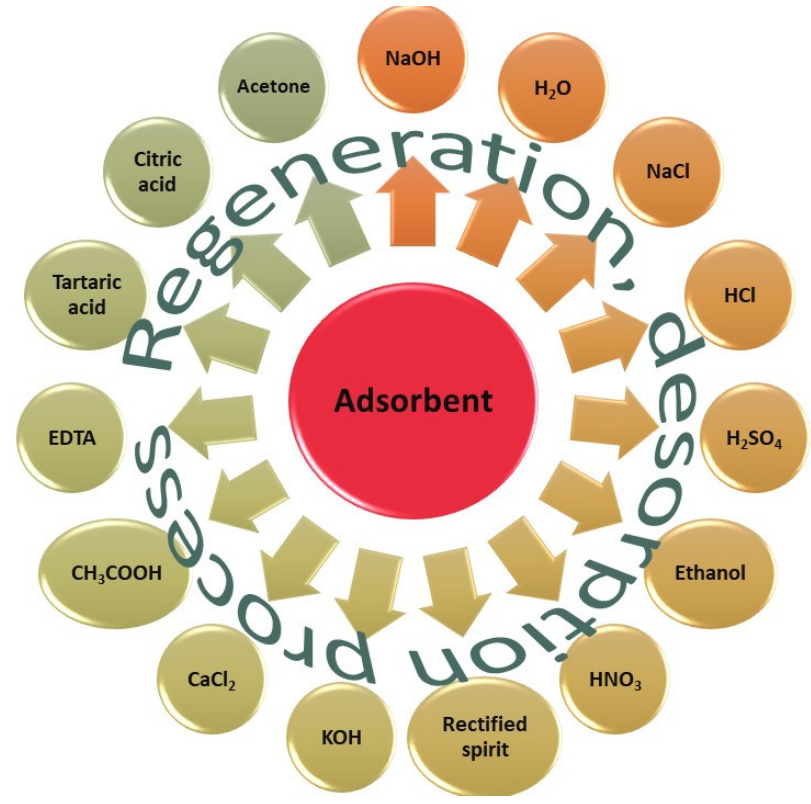
Figure 7. Possible eluents used to desorb contaminants from adsorbent materials.